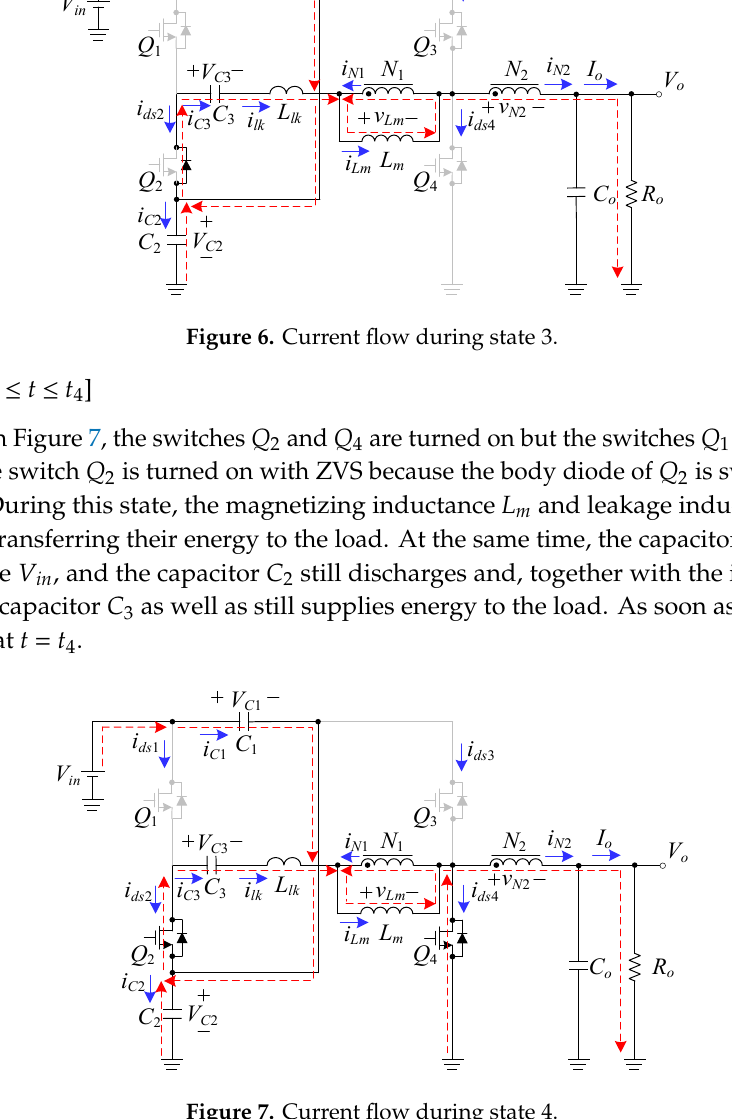
Figure 5. Current flow during state 2.